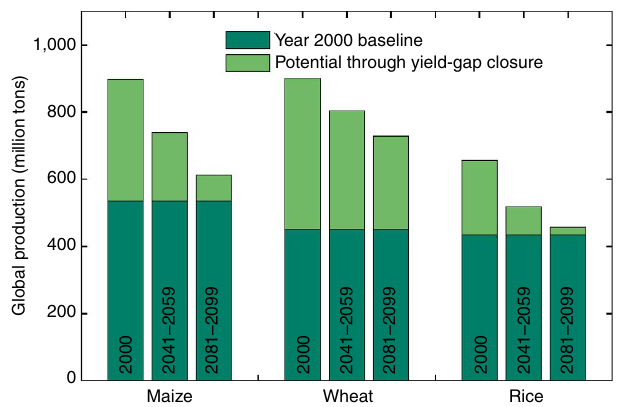
Figure 3 | The effect of climate change on production increases through agricultural intensification. The potential increases in global production of maize, wheat and rice that could be achieved by closing the yield gap (difference between actual and attainable yields) on current cropland are plotted for baseline, mid-century, and end-of-century climates (light green bars). For reference, these bars are imposed on top of actual production for ca. year 2000 (dark green bars), as calculated based on actual yields from Mueller et al. 4 and cropland area from Monfreda et al. 18